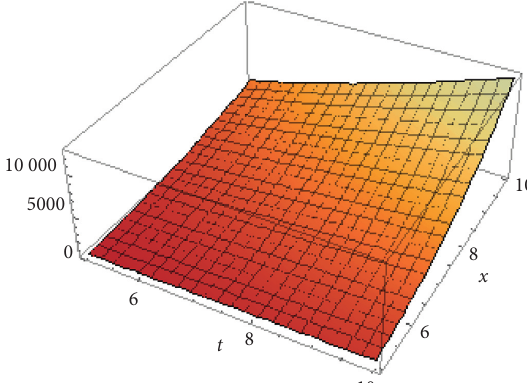
Figure 4: 3D plot of equation (73) for c � 0 . 75 ; β � 0 . 90 ; y �